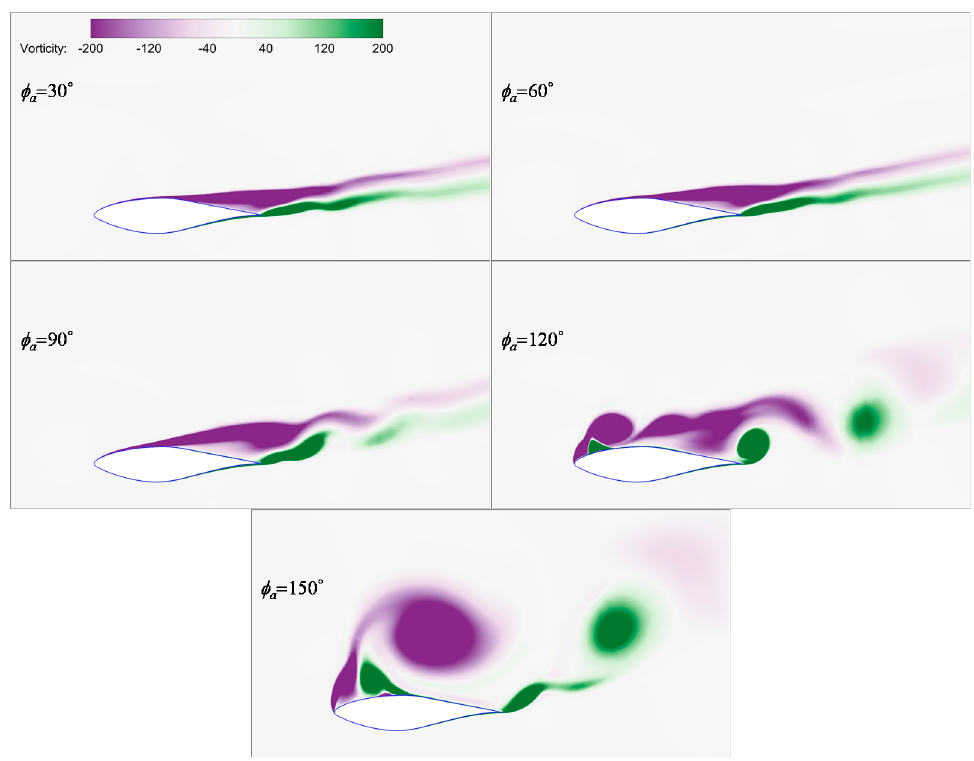
Figure 13. Development of the vorticity field around the 2D airfoil from ϕ a = 30° to ϕ a = 150°.